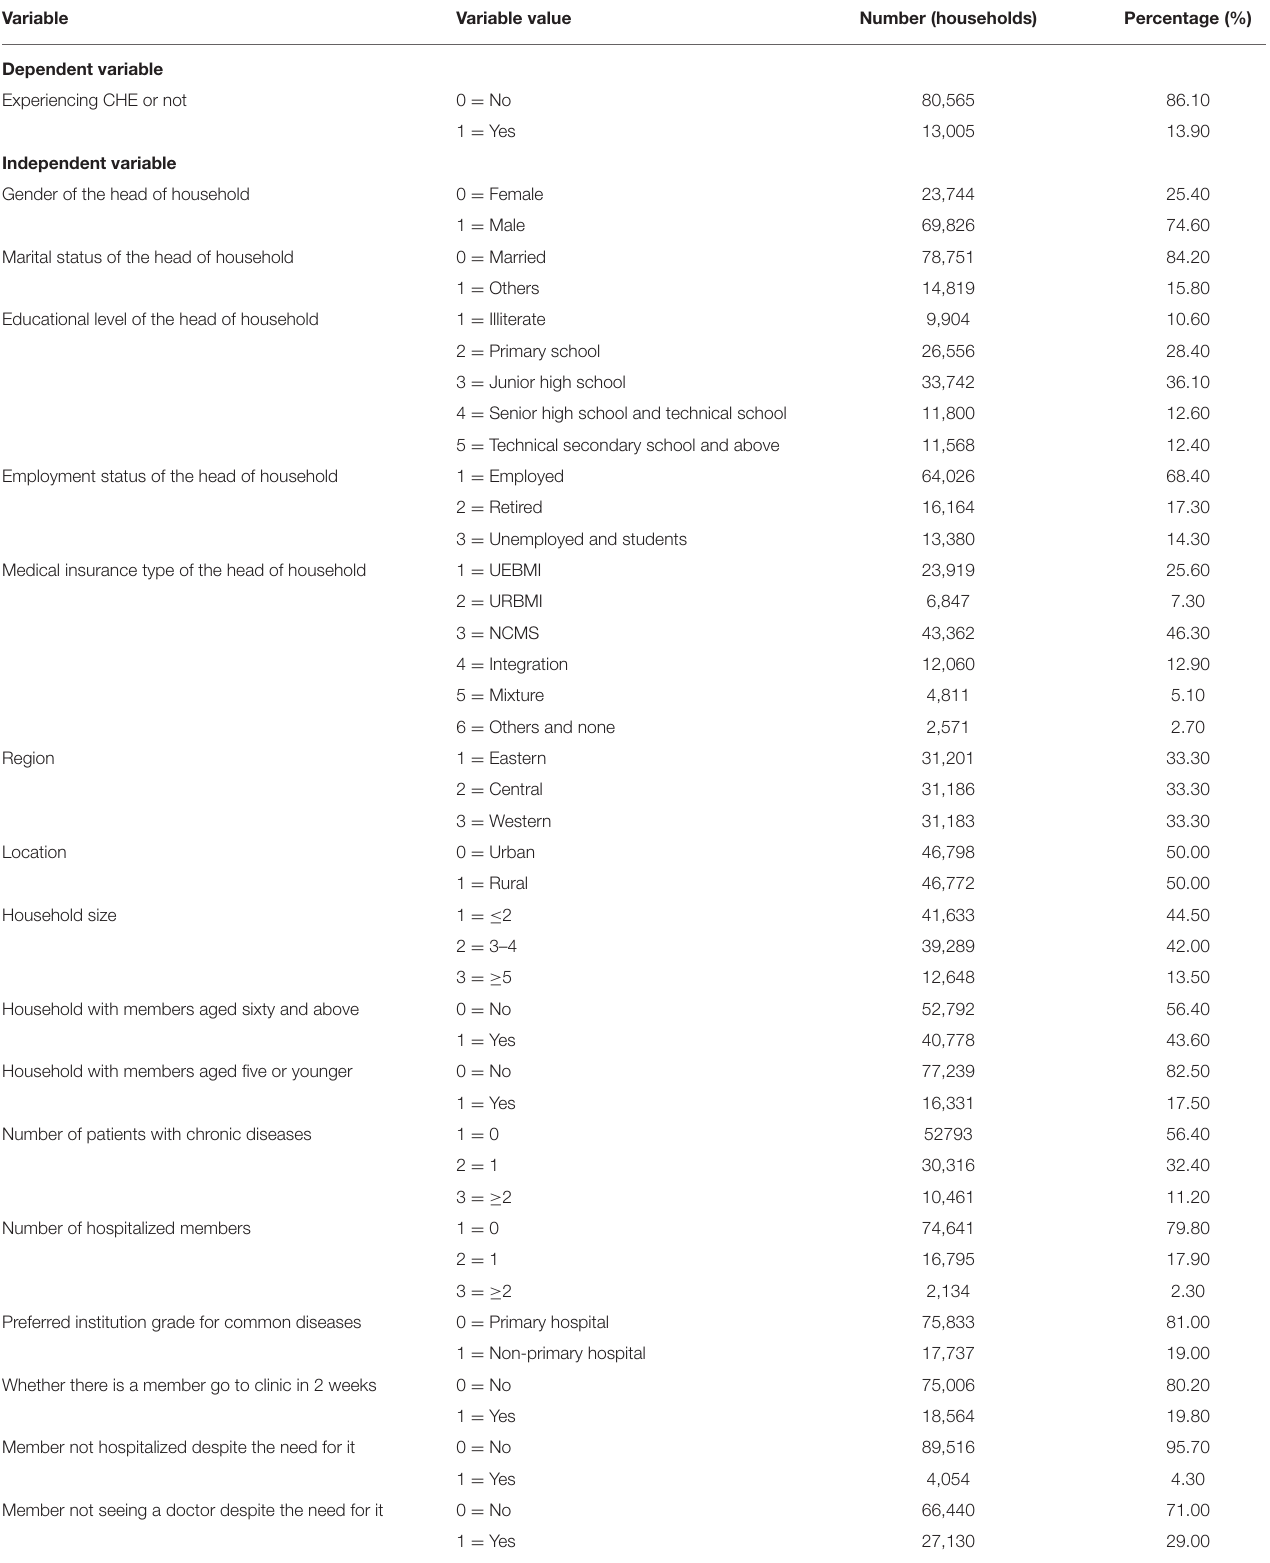
TABLE 1 | Basic information of respondents in the fifth